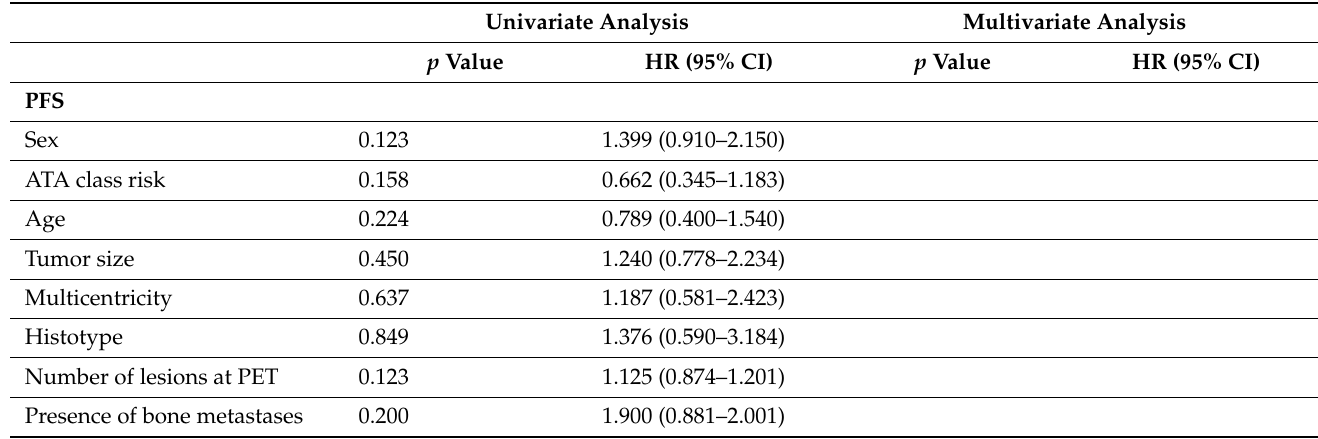
Figure 3. Kaplan–Meier curves relating to PFS and the PET/CT metrics (( a ) SUVmax; ( b ) SUVmean; ( c ) MTV; ( d ) TLG; ( e ) tMTV; ( f ) tTLG). Table 3. Univariate and multivariate analyses for PFS and